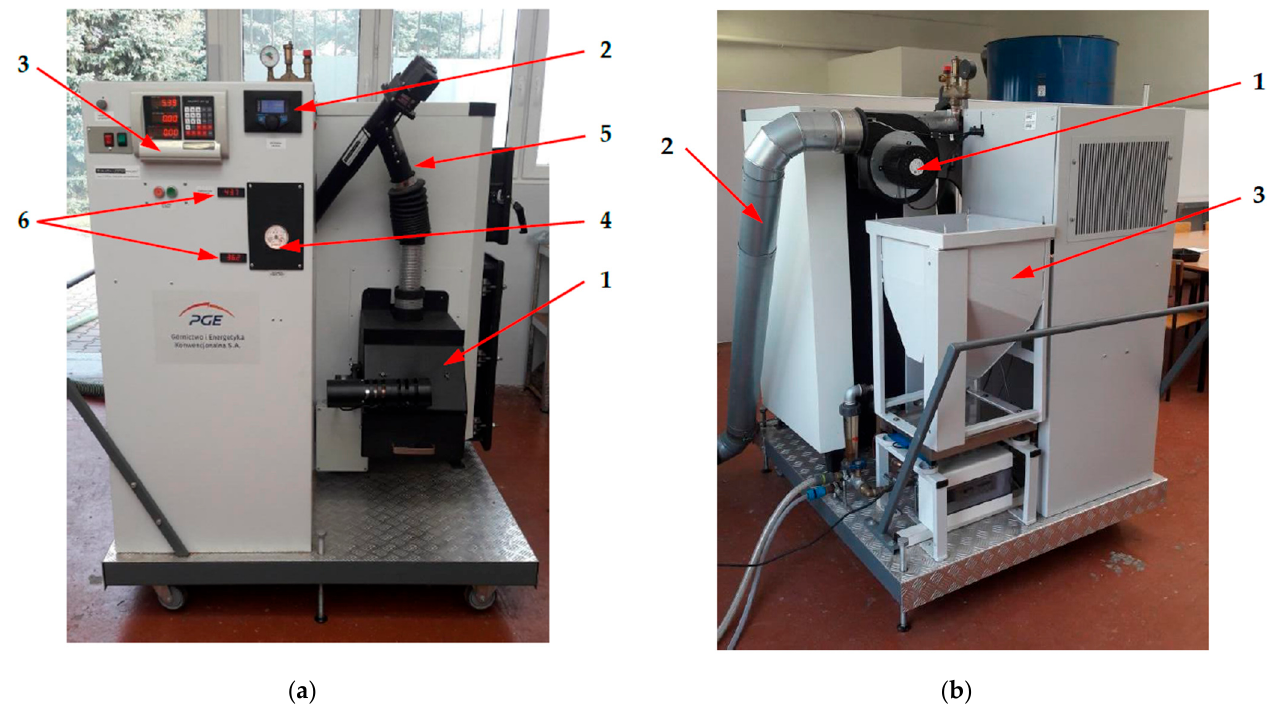
Figure 3. Experimental stand: ( a ) Front view: 1—gasification burner, 2—burner controller, 3—pellet weight measuring system, 4—water flow meter, 5—screw feeder, 6—water temperature indicator at the inlet at the outlet; ( b ) Back view: 1—exhaust fan, 2—chimney pipe, 3—pellet bunker.